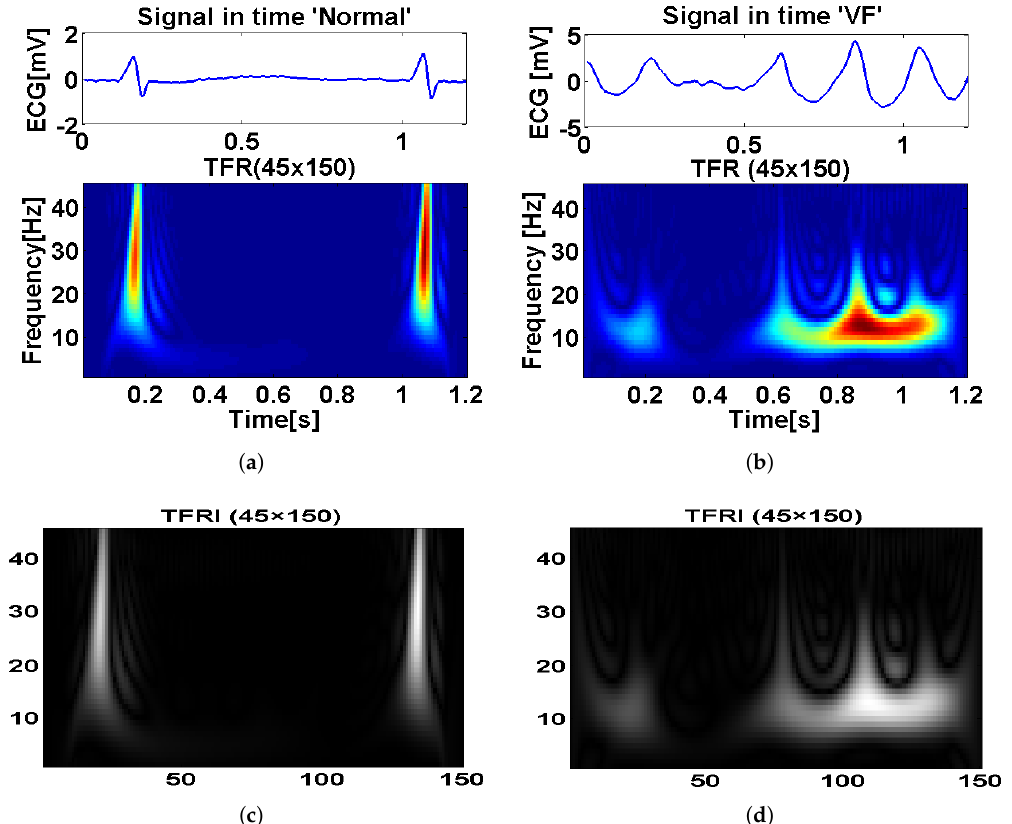
Figure 3. From top to bottom: ( a , b ) correspond to the original signal window and TFR ; ( c , d ) show the TFRI being 45 × 150 in size, for Normal ( c ) and VF ( d )